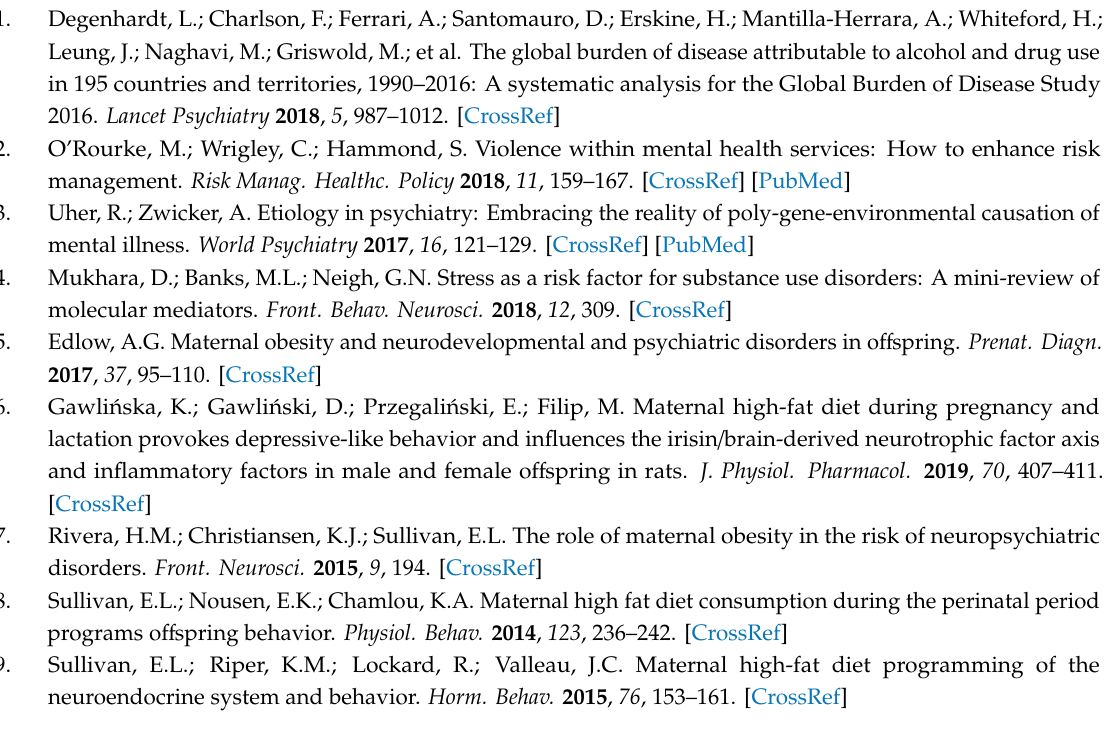
Figure S1: E ff ects of a high-fat (HFD), high-sugar (HSD), or mixed (MD) diet on (a) maternal body weight changes (as a percentage of weight gain compared to start weight) and (b) average daily energy intake during pregnancy and lactation. E ff ects of the modified maternal diets on (c) litter size and (d) birth body weight of female o ff